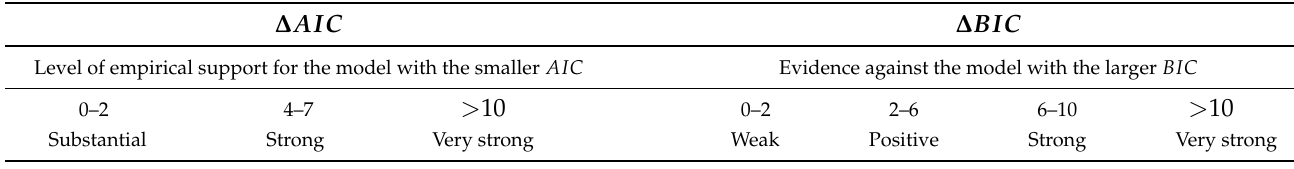
Table A2. The interpretation of differences ∆ AIC and ∆ BIC according to the calibrated Jeffreys’